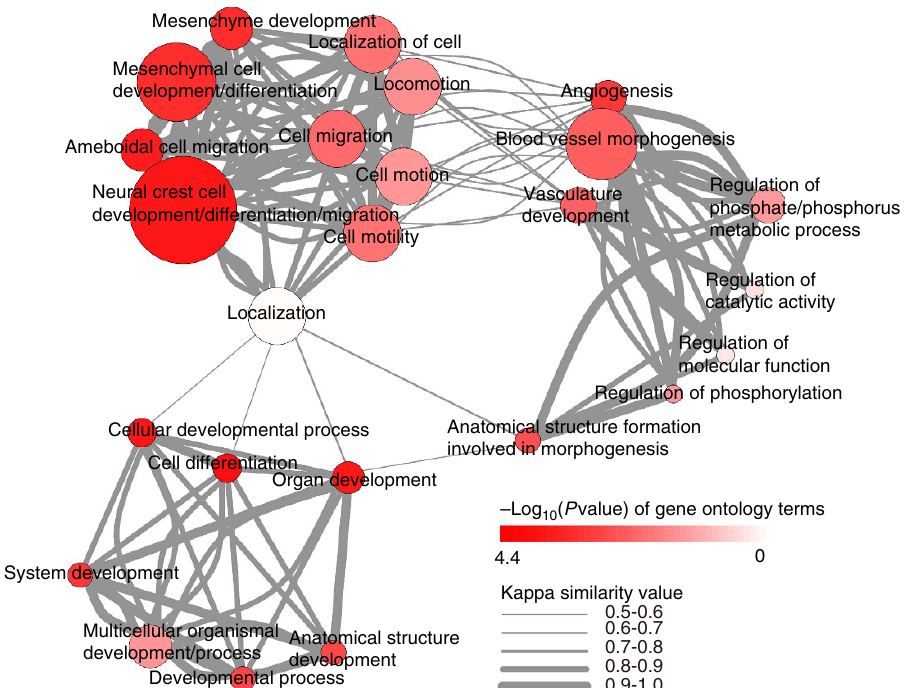
Figure 2 | Graphic display of the similarity among the 25 gene ontology terms and their P values. The P value (Fisher’s exact test) of each term and kappa similarity among terms were derived from the Database for Annotation, Visualization and Integrated Discovery (DAVID). The 25 nodes represents 25 gene ontology terms. The P values of the 25 nodes are indicated by the gradations in the colour red. The similarities between them are indicated by edges scaled according to their correlation (only correlations with a Kappa 4 0.5 are shown; the correlation are divided into 5 levels equally from 0.5 to 1) and node size represents connection times among